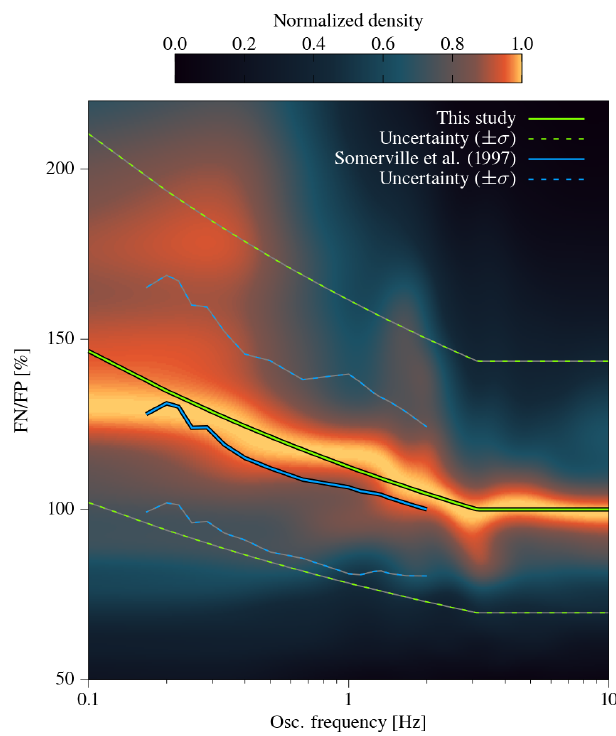
Figure 10. Kernel density estimate of the amplitude ratio of response spectra of fault-normal and fault-parallel components (FN / FP) with respect to oscillatory frequency. Beyond 2–3Hz FN / FP variations cease, as highlighted by our model and the model by Somerville et al.